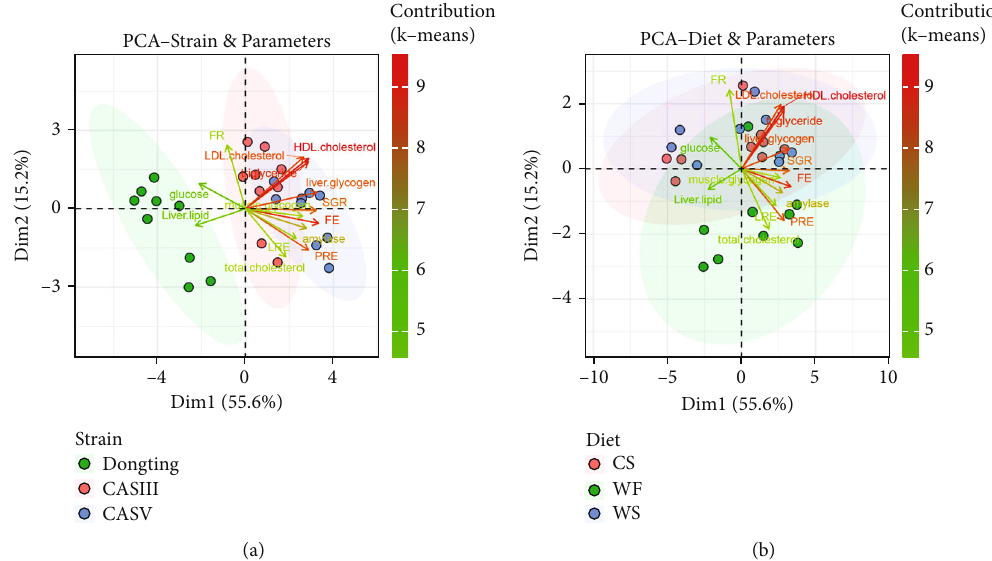
Figure 3: Principal component analysis (PCA) biplot of physiological responses from three gibel carp strains fed di ff erent dietary carbohydrate sources. (a) The PCA performed at the strain level. (b) The PCA performed at the carbohydrate source level. Arrows indicate the direction of increasing values for each variable. Colour coding indicates cluster membership determined by K -means clustering based on their scores on the main PCA